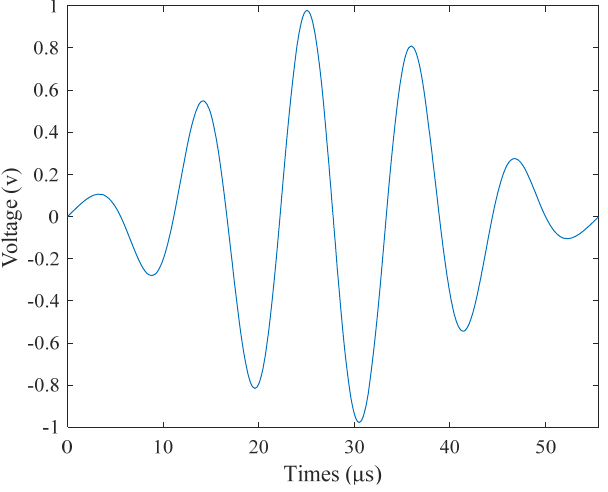
Figure 10. Excitation signal of 90 kHz.